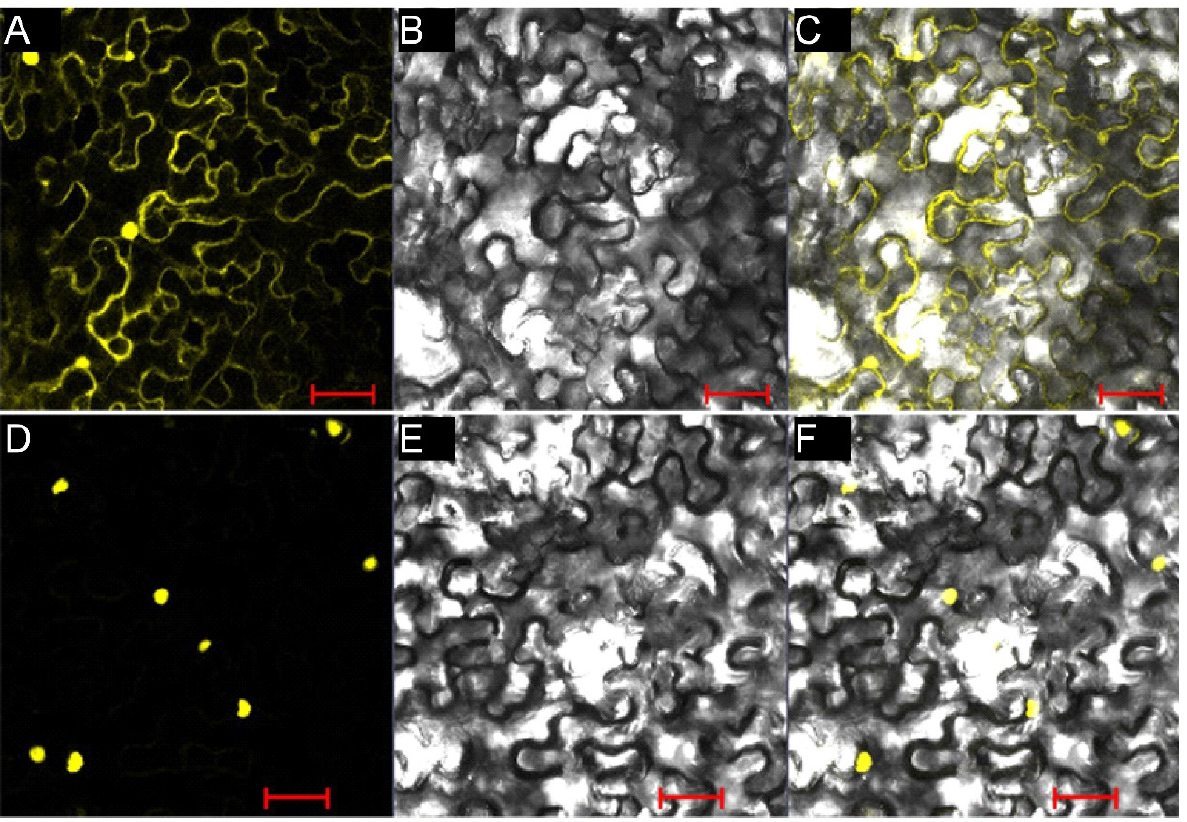
Figure 8. Subcellular localization of BjPHL2a . ( A – C ) YFP fluorescence from pCAMBIA1205 - YFP empty vector. ( D – F ) YFP fluorescence from pCAMBIA1205-YFP- BjPHL2a . ( A , D ) YFP fluorescence in a dark field. ( B , E ) Cell morphology in a bright field. ( C , F ) Overlay of bright-field and YFP signals. Scale bars = 50 µm.